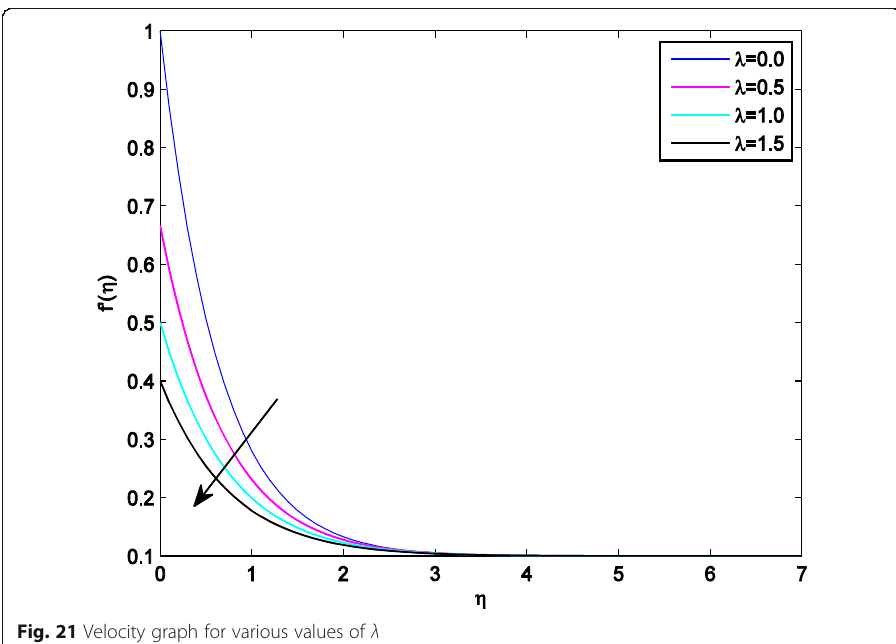
Fig. 21 Velocity graph for various values of λ